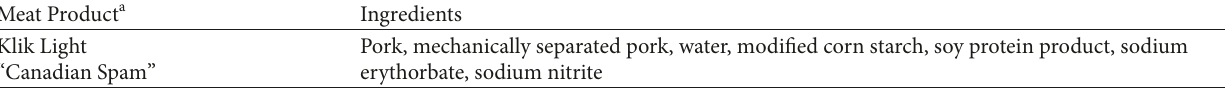
Table 10: Ingredients List of Processed Meats in the Present